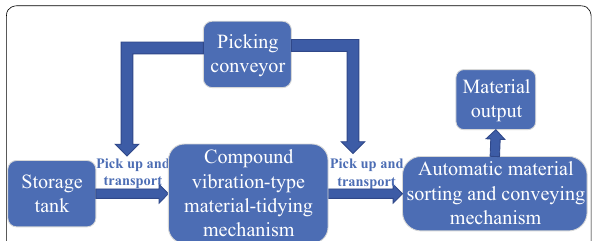
Figure 3 Overall module layout of automatic feeding